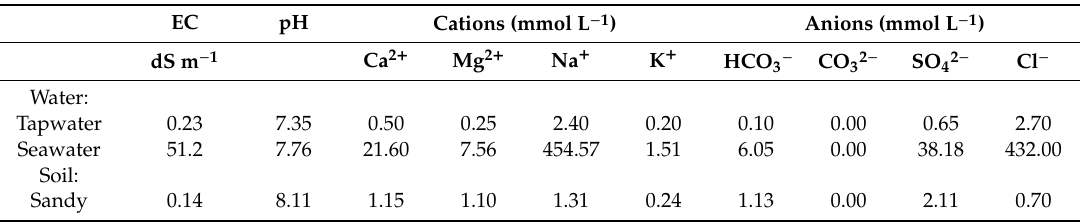
Table 3. Electrical conductivity (EC), pH, cations, and anions of irrigation water and soil used in the pot